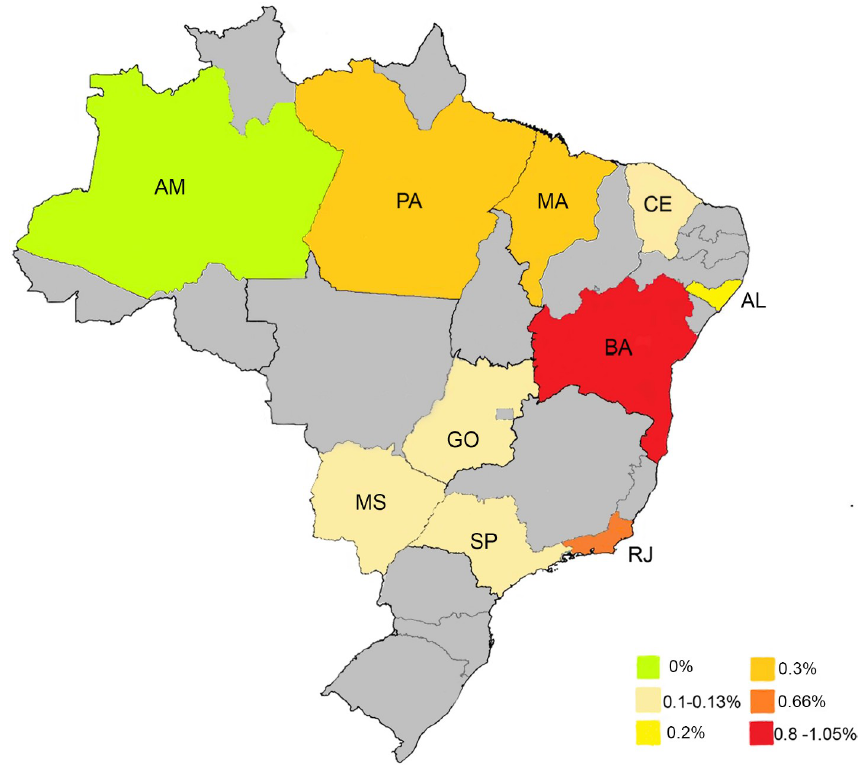
Fig 3. Representative map of HTLV-1 prevalence in pregnant women in different Brazilians states. The map was created with Paint 3D Windows and Adobe Photoshop CC 2018, using the open source map available at https://